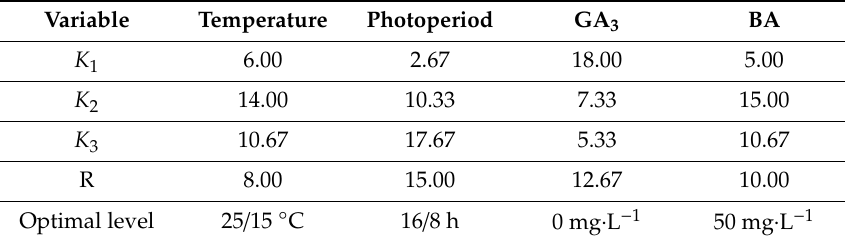
Table 1. Range analysis of L 9 (3) 4 test results for the number of runners.